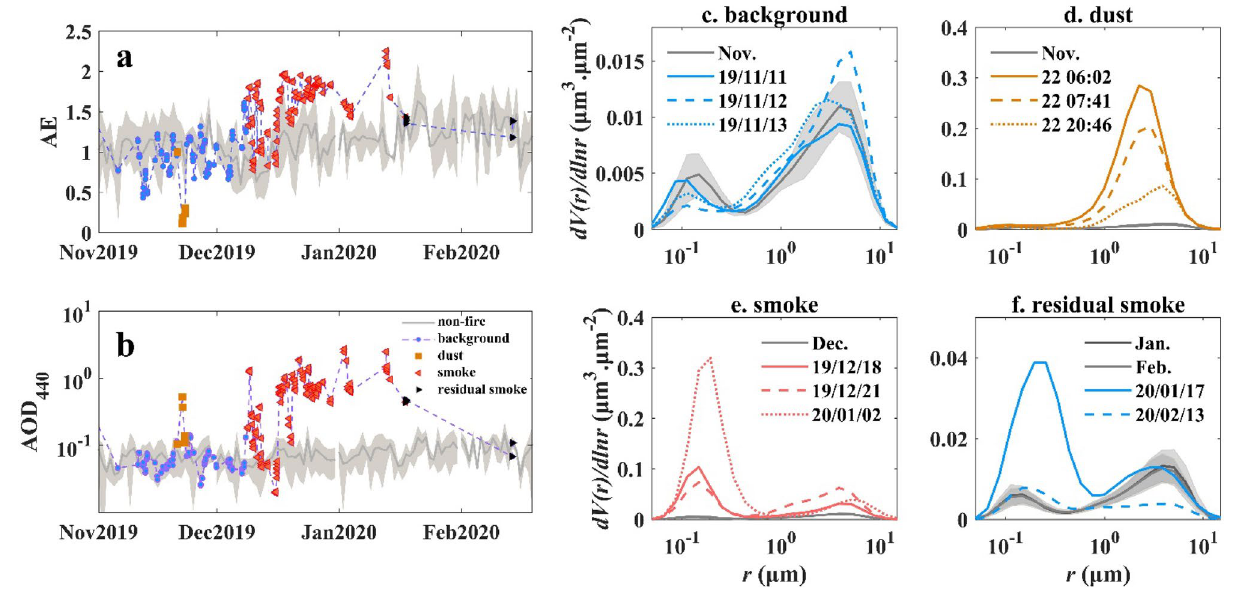
Figure 4. AERONET observations from November 2019 to late February 2020: AE ( a ) and total AOD 440 ( b ) and aerosol particles size distributions for the aerosol types of the study time: background ( c ), dust ( d ), smoke ( e ), and residual smoke ( f ) according to the method in Gómez-Amo et al. (2017).